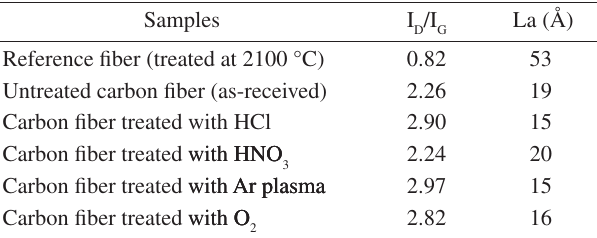
Table 3. Raman analysis – I and treated carbon fibers.